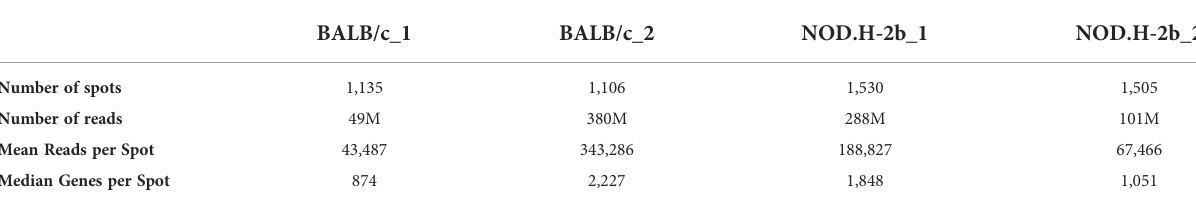
TABLE 1 QC metrics of Visium